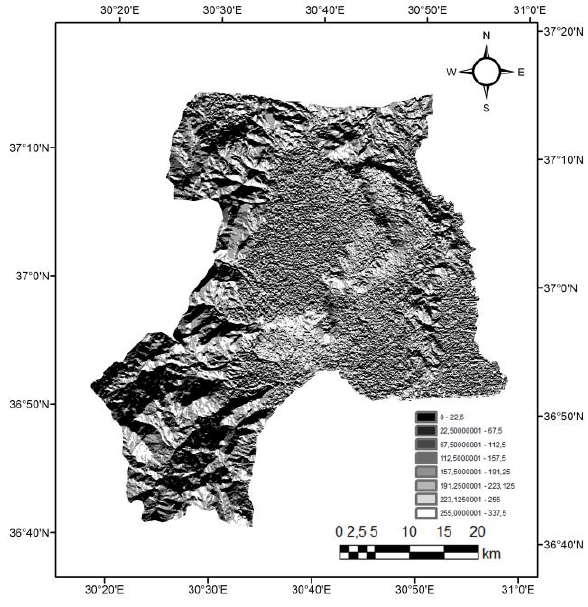
Figure 10. Aspect of the Study area